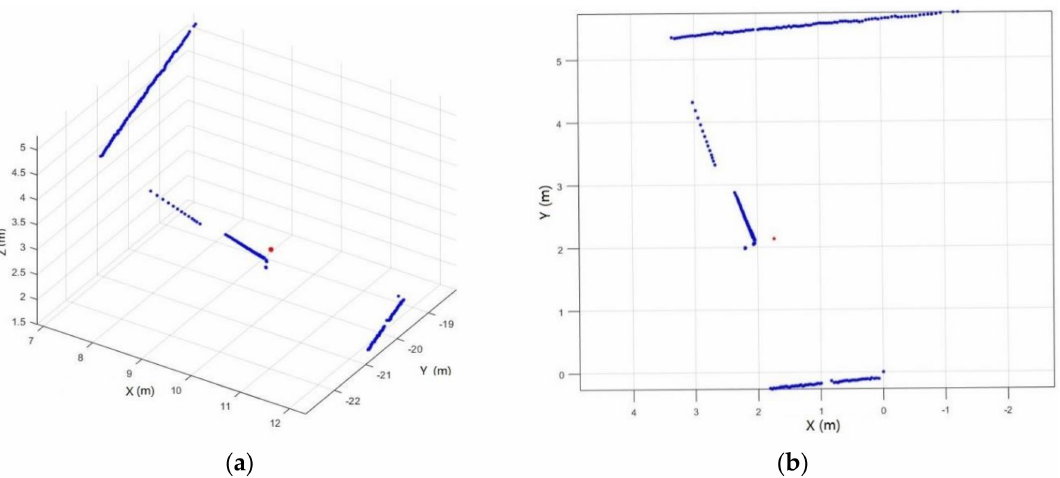
Figure 4. Example scanline before ( a ) and after ( b ) projection (red point: scanner position; blue point: scanline point).